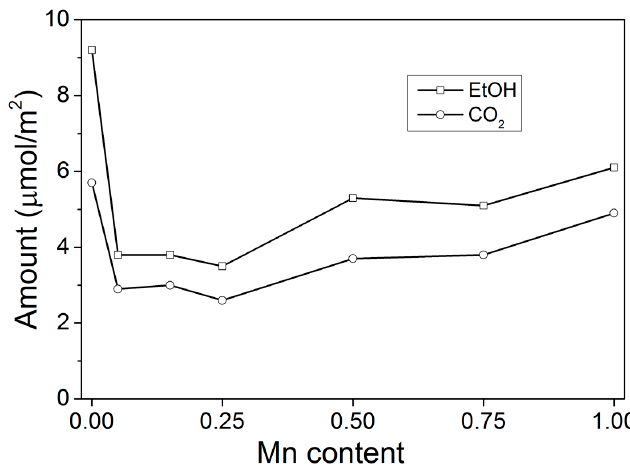
Figure 6. Specific amount of adsorbed ethanol and CO 2 produced during TPO as a function of the composition of Mn x Ce 1 − x catalysts.